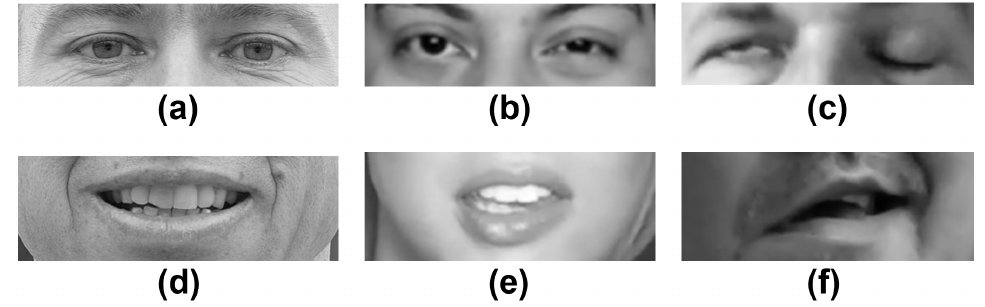
Figure 5. Facial analysis: ( a ) healthy eyes, ( b ) slight palsy and ( c ) strong palsy eyes; ( d ) healthy mouth, ( e ) slight palsy, and ( f ) strong palsy mouth. Palsy images were obtained from [9].